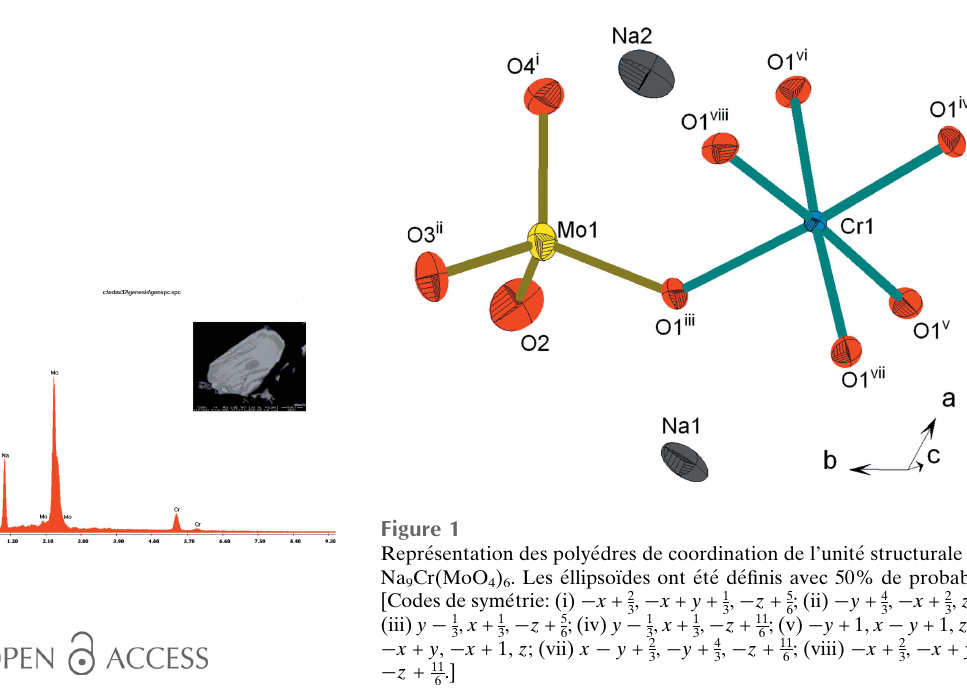
, (cid:2) x + y + 1 , (cid:2) z + 5 ; (ii) (cid:2) y + 4 , (cid:2) x + 2 , z (cid:2) 5 3 3 6 3 3 6